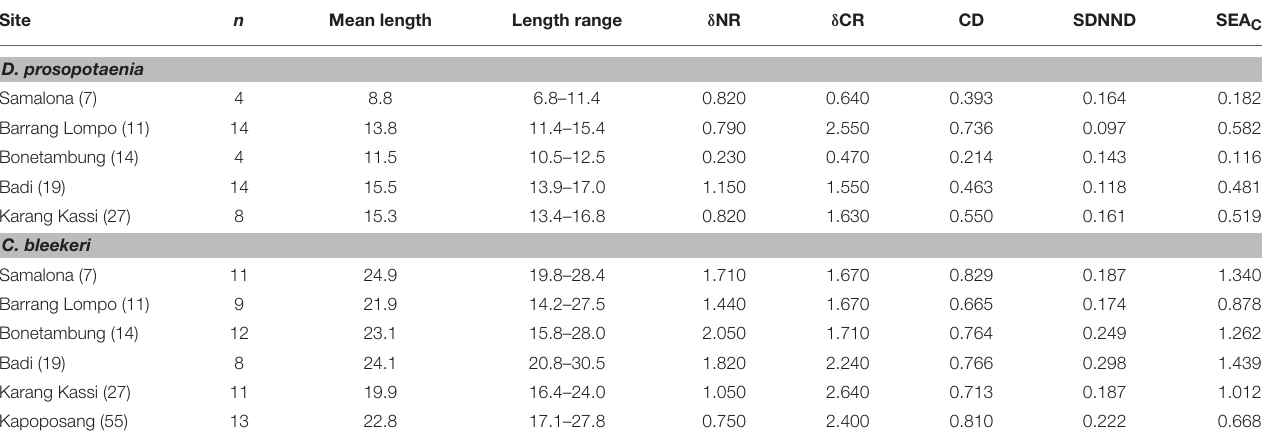
TABLE 3 | SIBER and Layman’s isotopic niche metrics for both species of herbivorous fishes. Site n Mean length Length range δ NR δ CR CD SDNND SEA